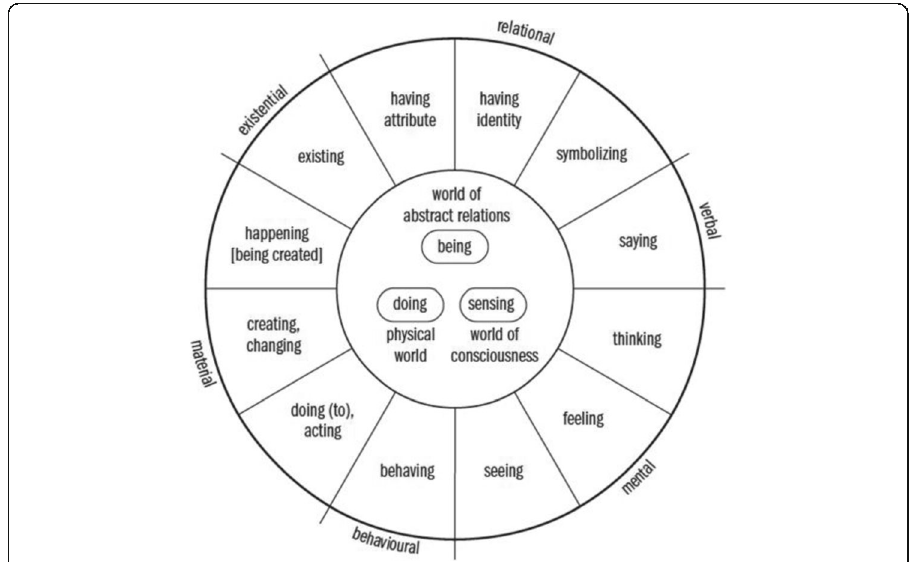
Fig. 1 The grammar of experience: types of process in English (Halliday and Matthiessen 2004: